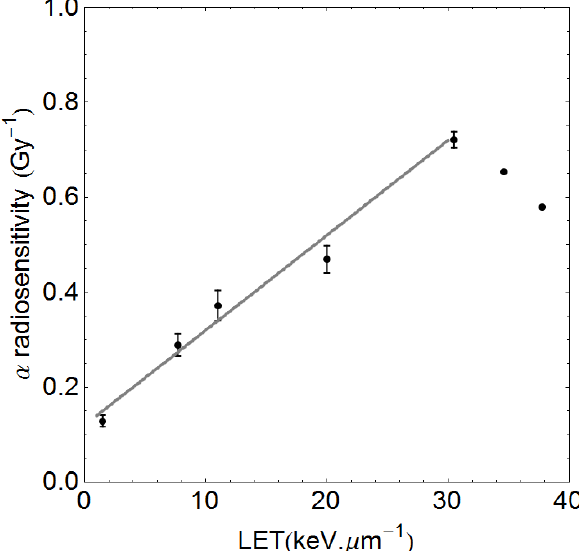
Figure 3. Data of Belli et al . [11] showing the linear rise in α with linear energy